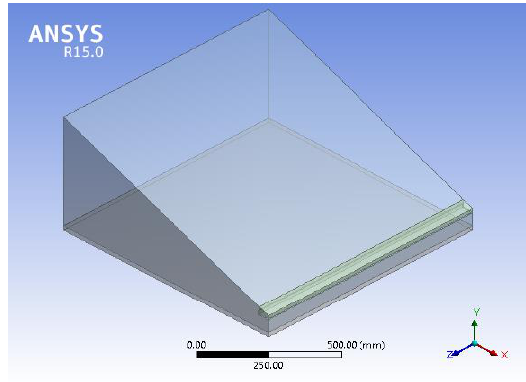
Figure 3. Geometric model of the single-slope solar still.